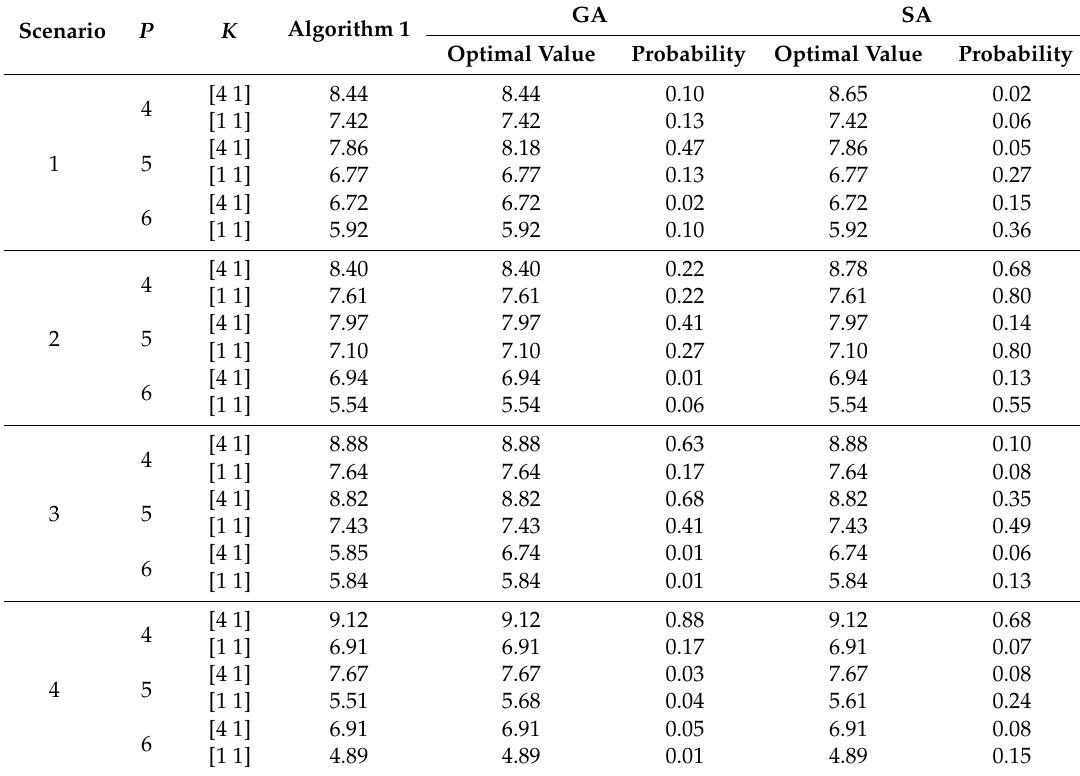
Table 4. Simulation Results Obtained With Algorithm 1, GA, and SA for